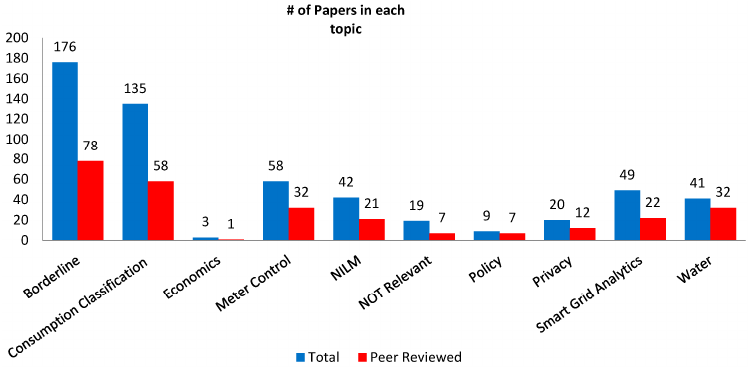
Figure 1. Category distribution after abstract screen. Total includes all types of written material from papers, conferences, workshops etc. Peer-reviewed only include journal papers.